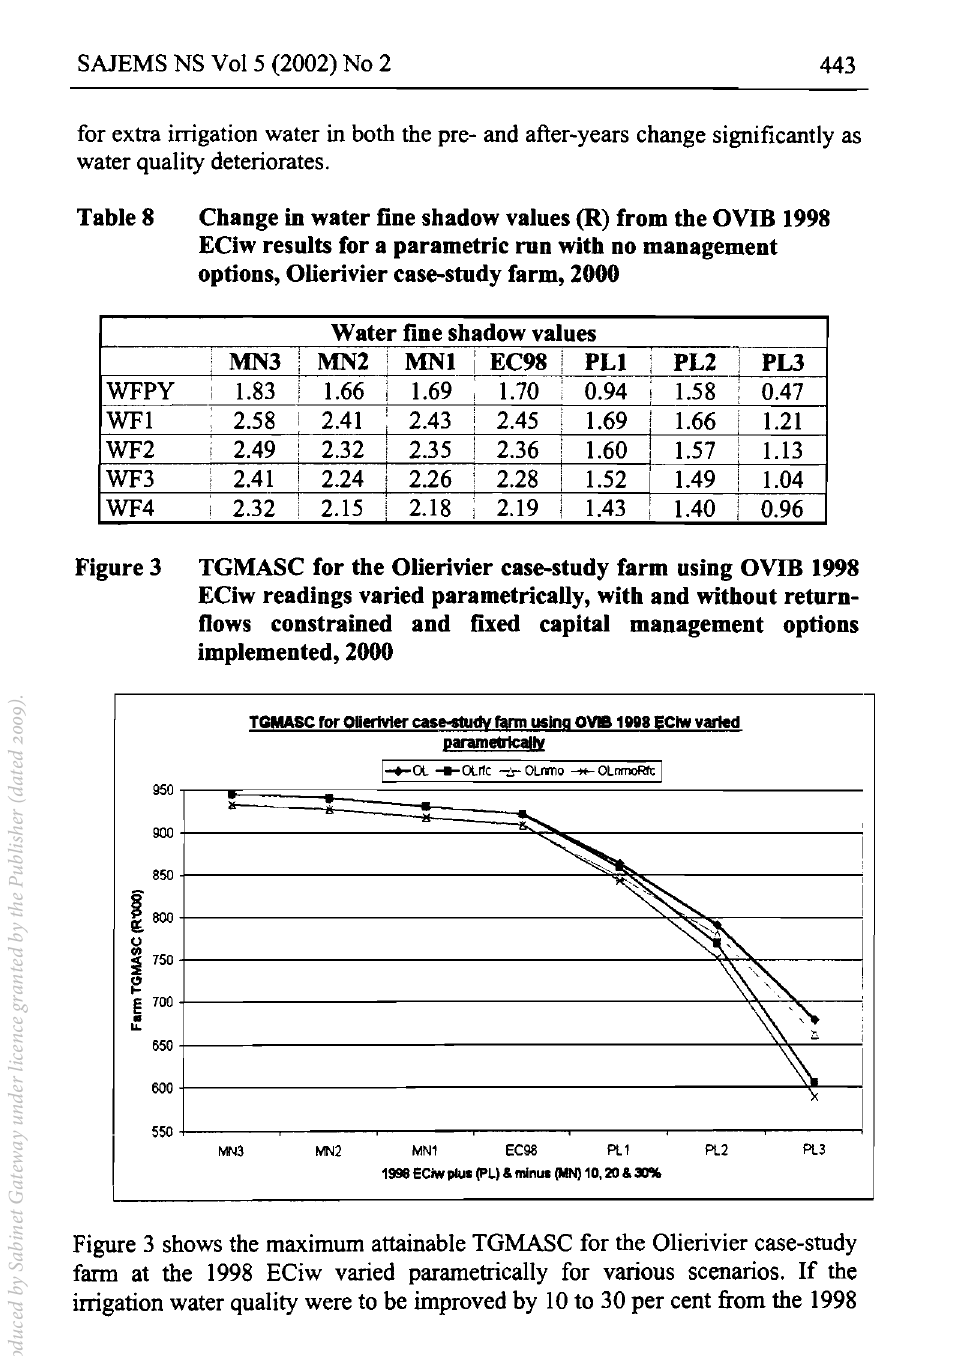
Change in water fine shadow values (R) from the OVIB 1998 ECiw results for a parametric run with no management options, Olierivier case-study farm, 2000